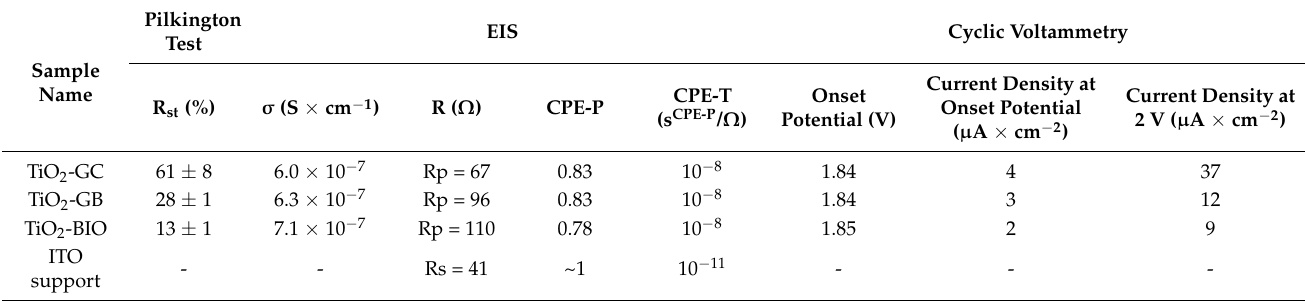
Table 4. Degradation of stearic acid after 100 min, R and CPE data from EIS fitting, and data from cyclic voltammetry under UV light.